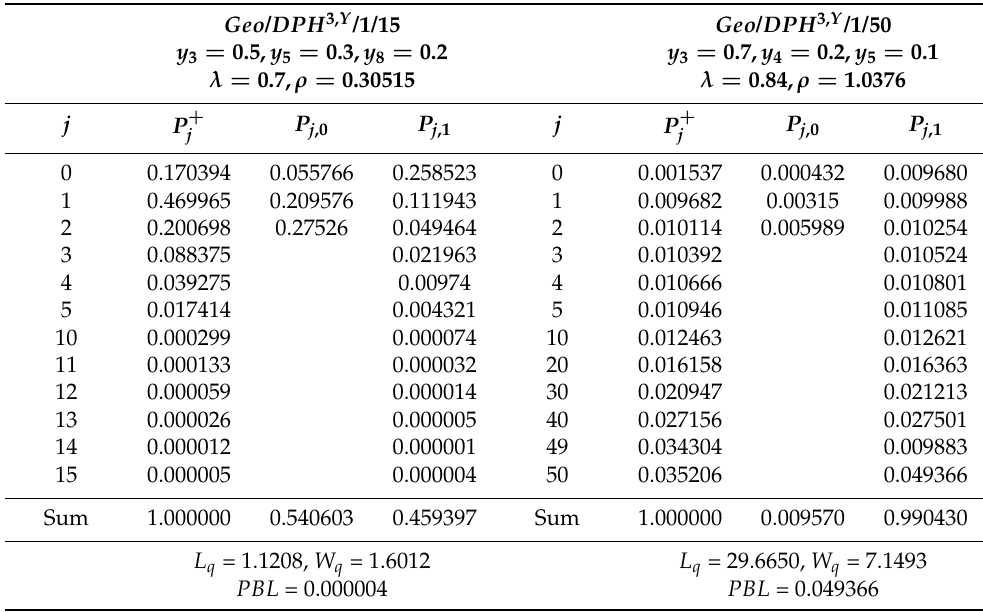
Table 2. Queue-length distributions at various epochs for the Geo / DPH 3, Y /1/15 and Geo / DPH 3, Y /1/50 queues. Geo / DPH 3, Y /1/15 Geo / DPH 3, Y